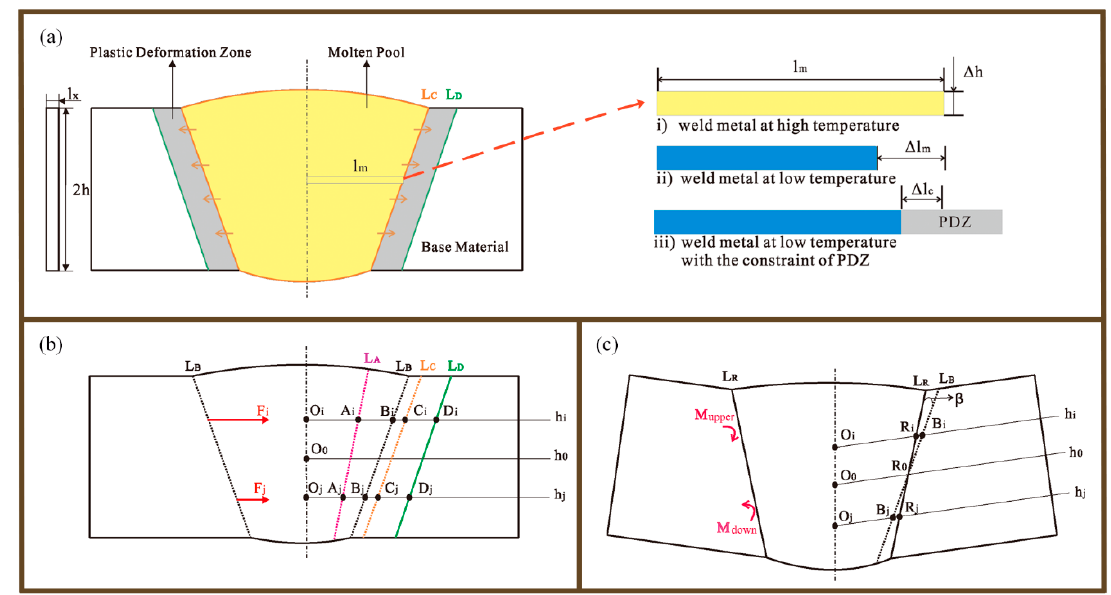
Figure 1. Theoretical model of angular distortion in fusion welding. ( a ) Schematic diagram of the weld seam cross-section when melting and cooling. ( b ) The constraining forces at different heights. ( c ) The bending moments M upper and M down and the angular distortion β .